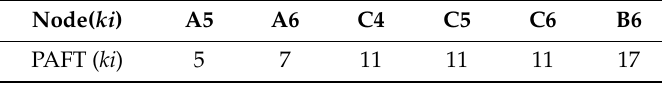
Table 9. The predecessor pointer adjustment (PPA)